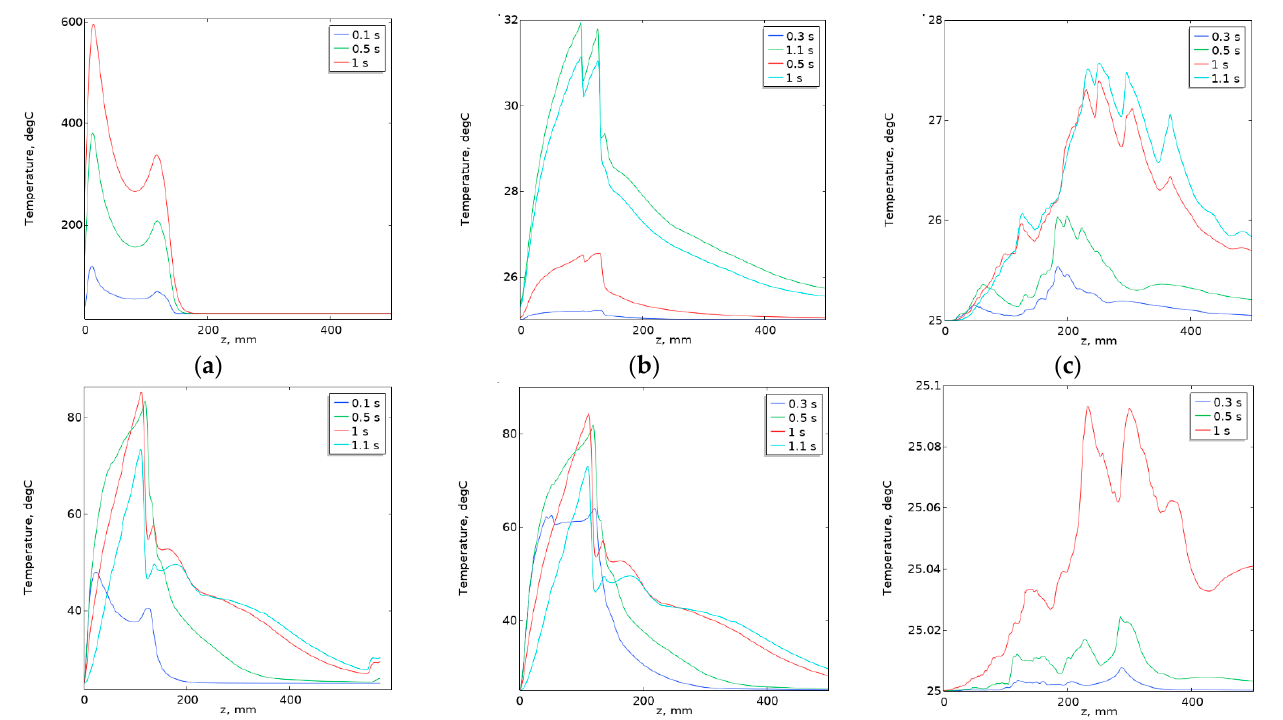
Figure 7. Temperature profiles on a metalized copper collector with a polymer layer ( top ) and an all-copper collector ( bottom ): ( a ) on the inner copper surface, ( b ) the outer surface of the copper layer at the boundary with water, and ( c ) the outer surface of the water-cooling channel.